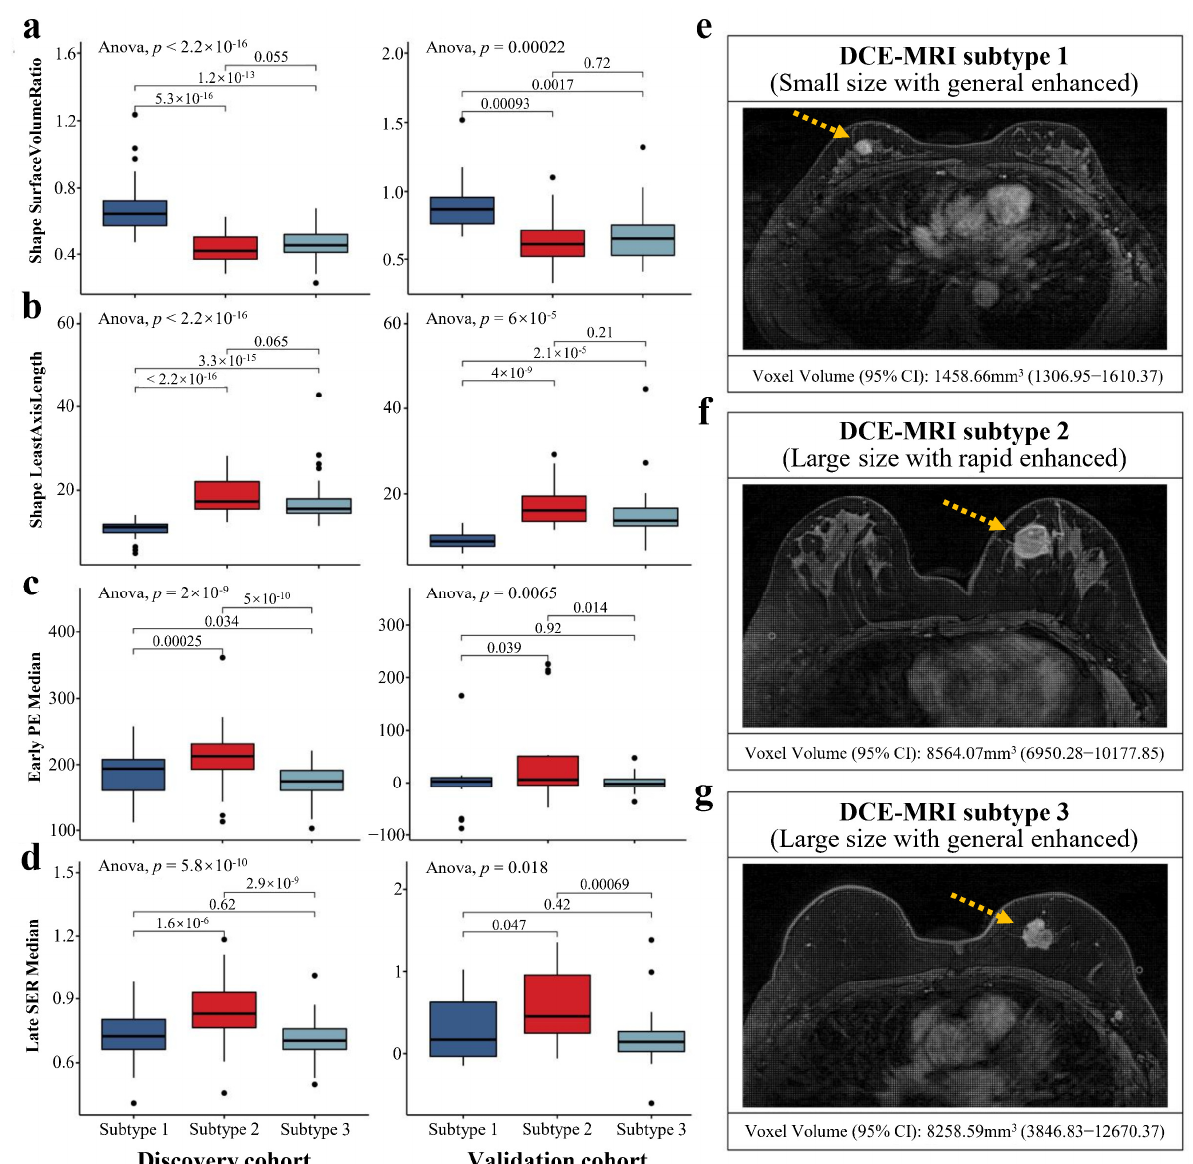
Figure 3. Significant differences in tumor sizes and enhanced patterns shaped the imaging subtypes.